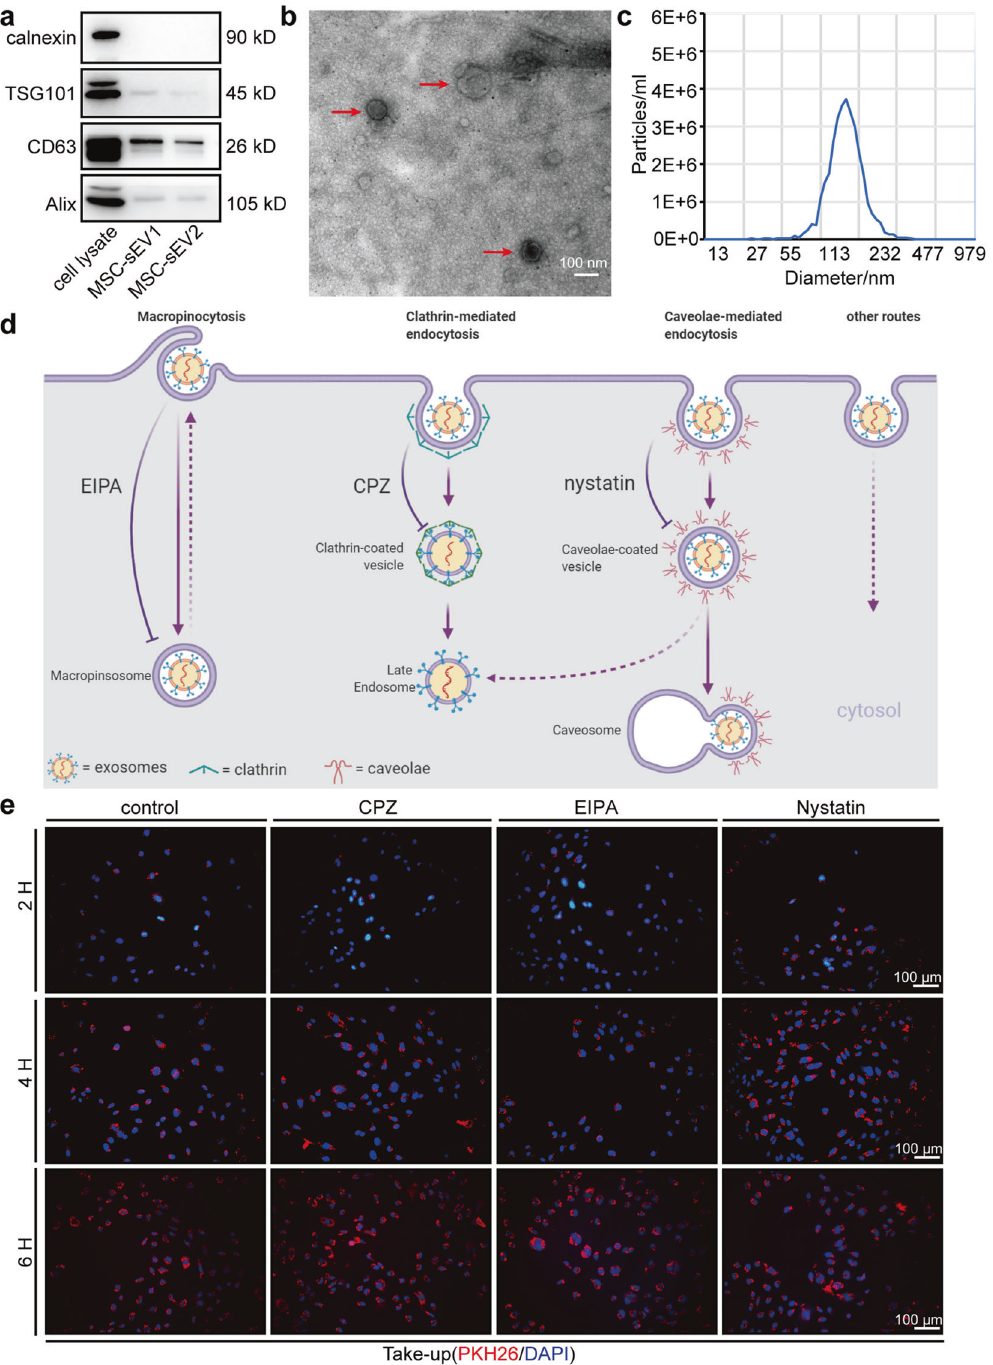
Fig. 1 Characterization of MSC-sEV and their active internalization by HUVECs. a Representative images of western blot analysis showing the biomarkers of sEV, including TSG101, CD63, and Alix. Calnexin was used as a negative control (MSC-sEV1, 2.1 mg protein/mL MSC-sEV; MSC- sEV2, 0.21 mg protein/mL MSC-sEV). b Transmission electron microscopic images of MSC-sEV (scale bar, 100 nm). c Nanoparticles tracking analysis reveals the particle distribution of exosomes in various sizes. Within every nanometer diameter sets, the value of the ordinate represents the mean particle number. d Schematic illustration of the different types of endocytosis and their respective inhibitor (Created with BioRender.com). e Uptake of MSC-sEV by HUVEC pretreated with signal inhibitors chlorpromazine (CPZ), nystatin, or 5-(N-ethyl-N-isopropyl) amiloride (EIPA) for 1 h. Cells were incubated with the indicated inhibitors for 1 h before and during the incubation with MSC-sEV. HUVECs incubated with 200 ng/ μ L PKH26-labeled MSC-sEV for the indicated times, and uptake of MSC-sEV was determined by fl uorescence microscopy (scale bar, 100 μ m)